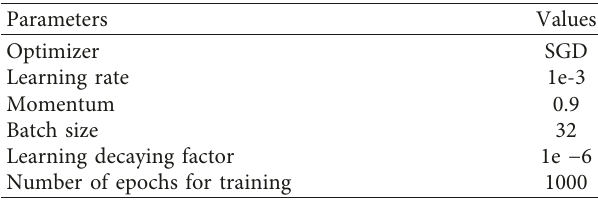
Figure 7: Confusion matrix of proposed three CNN approaches in two public dataset. (a) KACD dataset. (b) Tumor dataset. Table 3: Parameter configuration of the